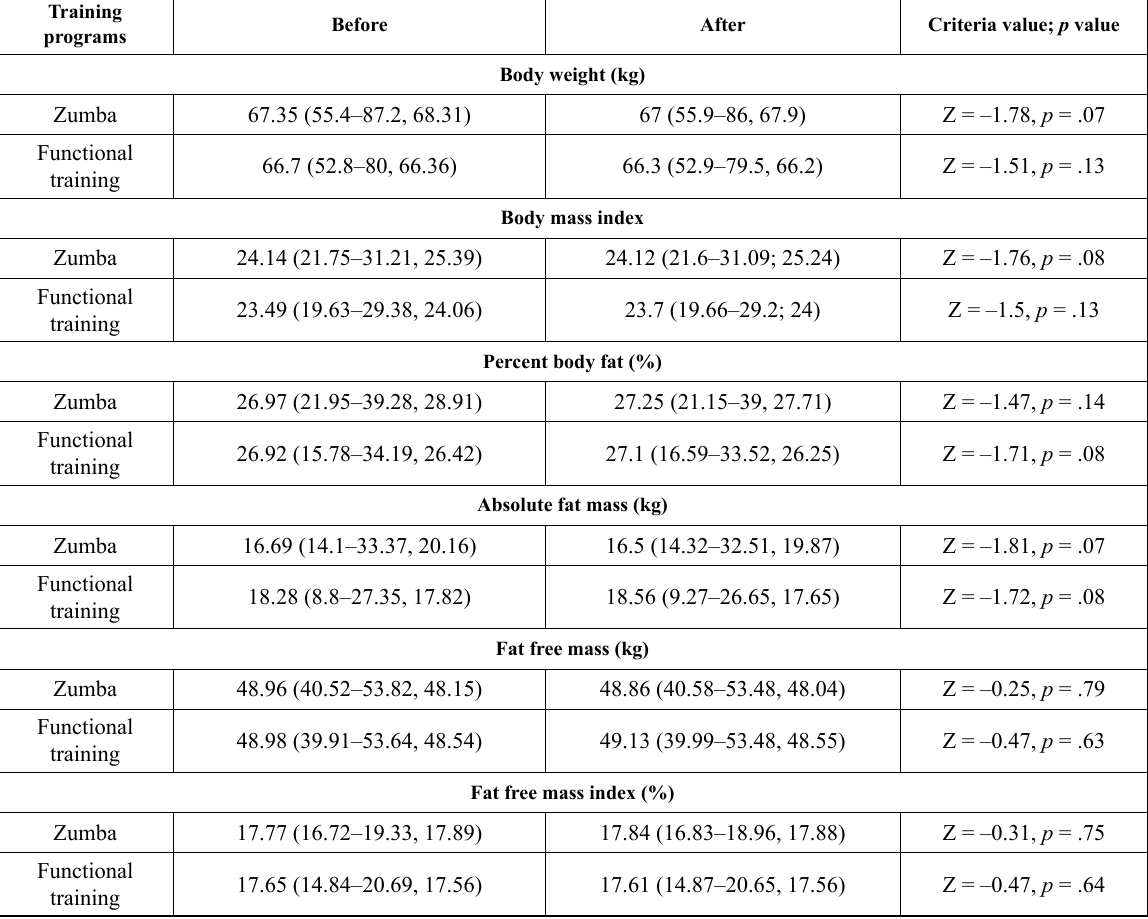
Table. Changes in body composition parameters after Zumba and Functional training